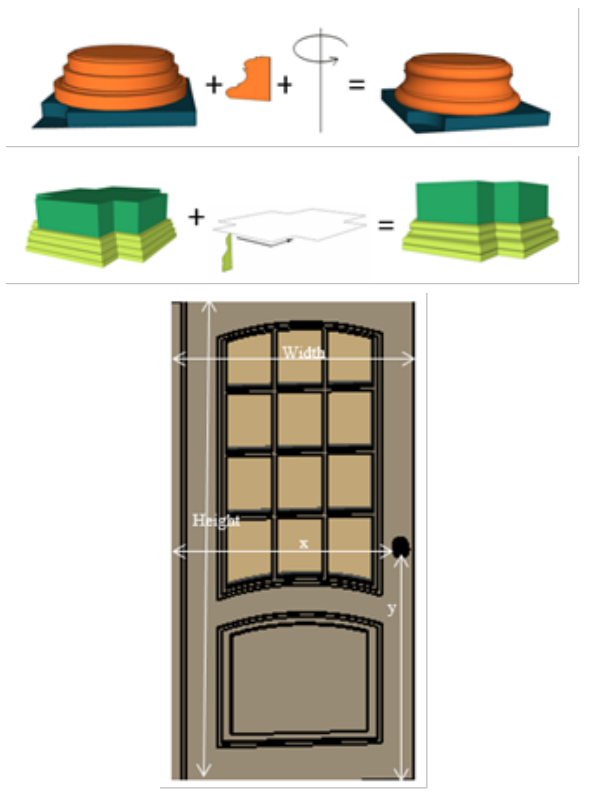
Fig. 5: The description information about the elements could be obtained from documentation data and then digitized to parametric object library.